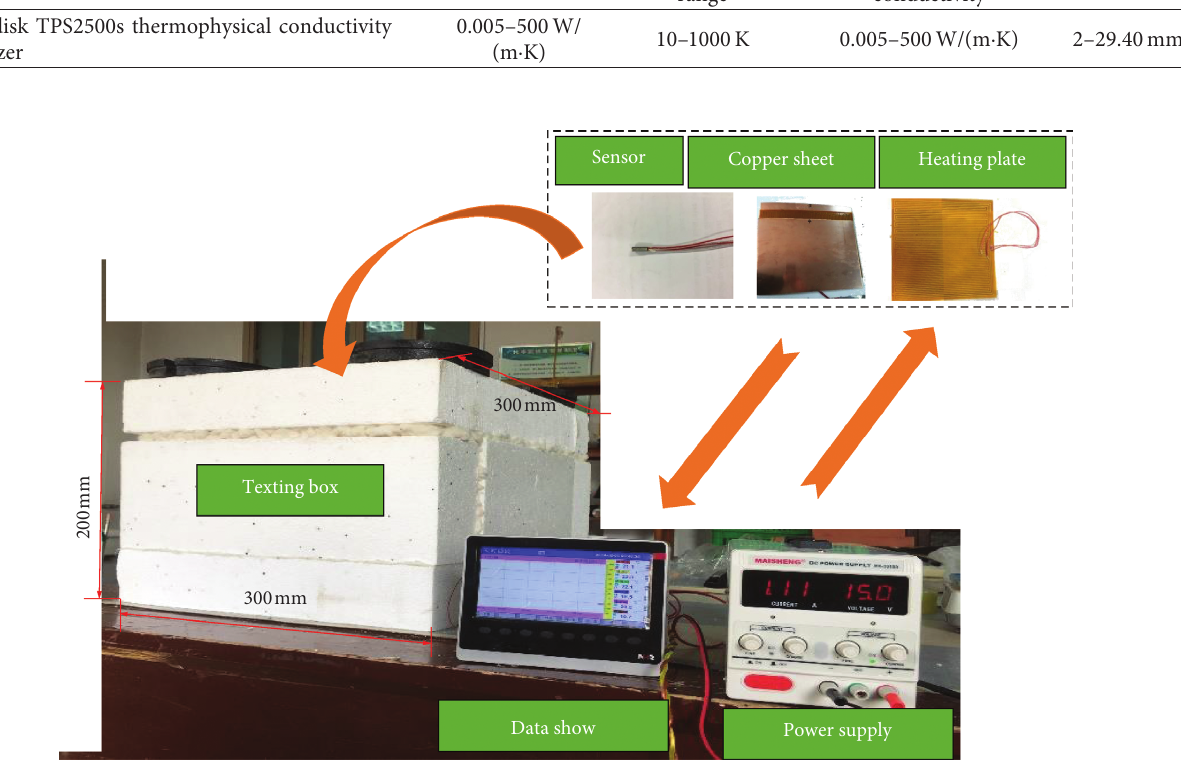
Figure 5: Self-made quasi-steady state tester. Table 4: Main technical parameters of the DB-250B electric heating temperature blast